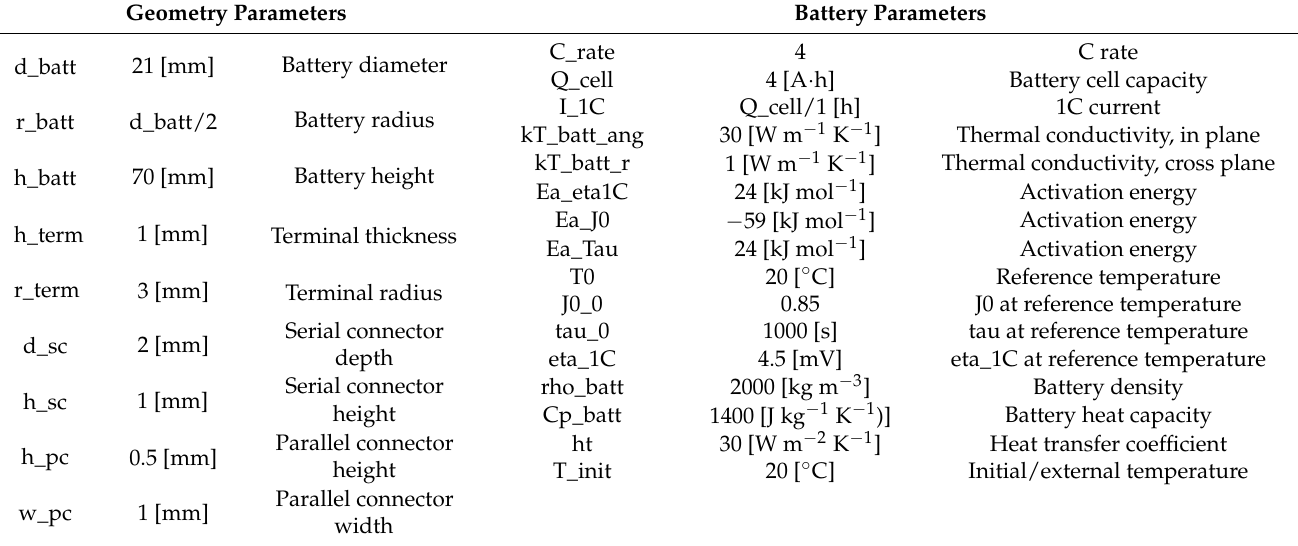
Table 2. Geometry dimension and electrochemical parameters of the battery